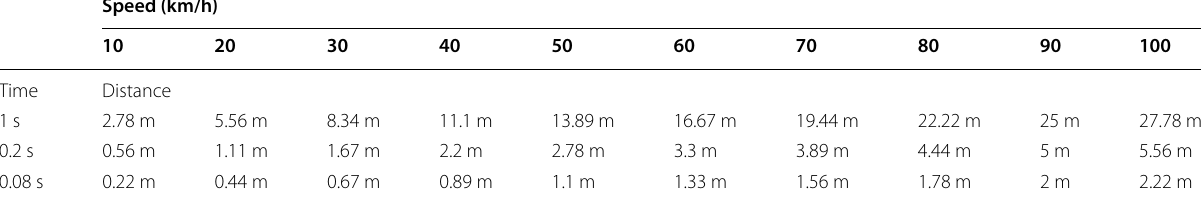
Table 6 Distance travelled by an object per unit of time at a constant speed Speed